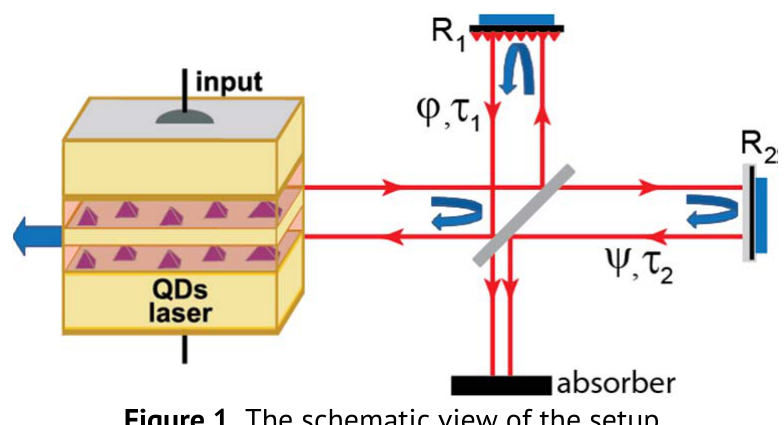
Figure 1. The schematic view of the